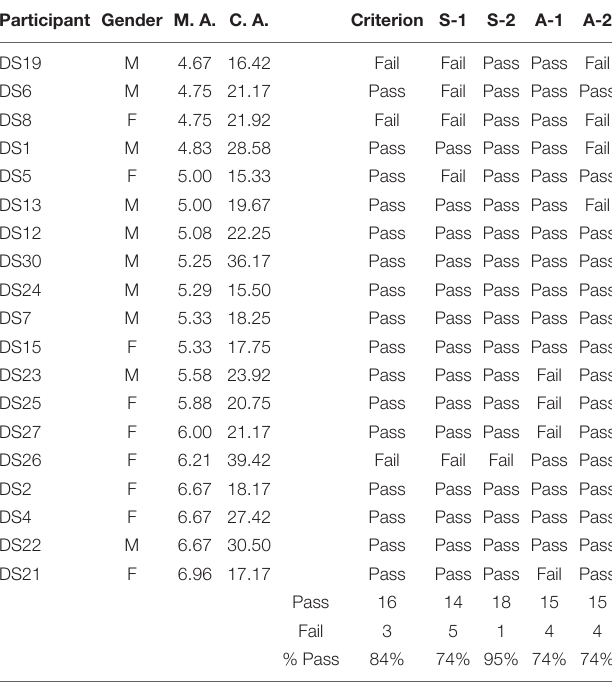
TABLE 3 | Individual performance of participants with DS in the homing